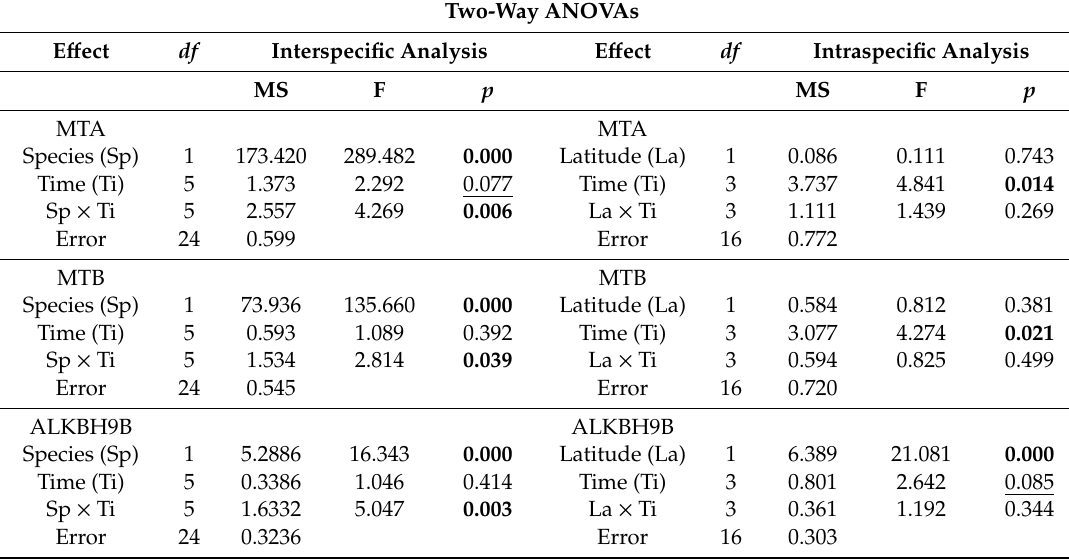
Table 4. Results of two-way ANOVAs conducted on − ∆ CT values of individual GOIs for inter- ( C. nodosa vs. Z. marina ) and intraspecific ( Z. marina at di ff erent latitudes) comparisons. p < 0.05 are in bold; p < 0.1 are underlined.